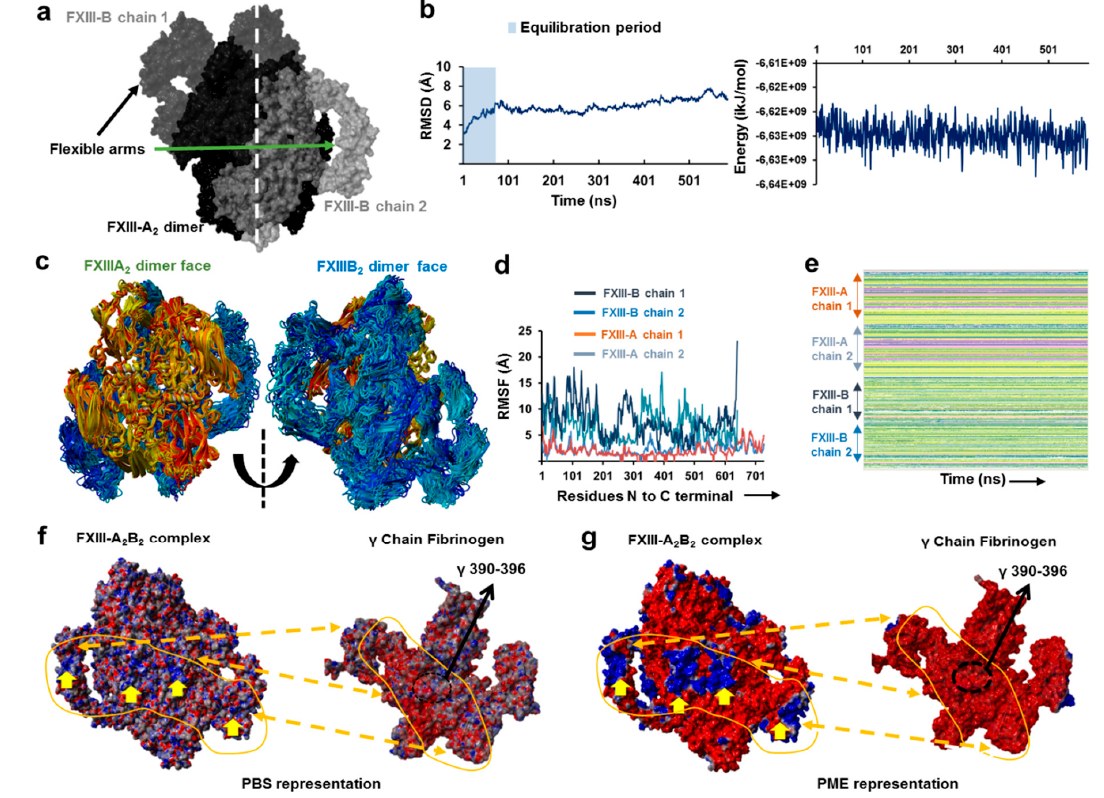
Figure 3. The all-atom structure of the FXIII-A 2 B 2 complex. ( a ) is the symmetrical representation of the best modeled all-atom structure of the FXIII-A 2 B 2 complex. The structure has been depicted by its molecular surface in di ff erent shades of black and gray for the individual chains of FXIII-A and FXIII-B subunits. ( b ) shows the C- α backbone RMSD and the total energy graphs for the MD simulation conducted on the FXIII-A 2 B 2 complex structure model. ( c ) are aligned simulation snapshots from the MD simulation conducted on FXIII-A 2 B 2 complex structure represented with FXIII-A subunit face (left) and the FXIII-B subunit face (right). The snapshots of FXIII-A and FXIII-B subunits are depicted in ribbon format with colors ranging between yellow-red and cyan-blue for either subunit, respectively. ( d ) shows the graph representing RMSF for the FXIII-A 2 B 2 complex structure MD simulation, with individual chains represented by di ff erent color as mentioned in the inset. ( e ) represents the secondary structure profile of individual chains of FXIII-A and FXIII-B subunits for the FXIII-A 2 B 2 complex structure MD simulation. ( f ) is the PBS-based electrostatic surface representation of the FXIII-A 2 B 2 complex structure (left) and γ chain of fibrinogen (right) taken from fibrinogen crystal structure (PDB ID: 3GHG). Red color indicates negative surface electrostatic potential, whereas blue represents positive potential. Indicated positive electrostatic patches on the FXIII-A 2 B 2 complex structure are likely to interact with negatively charge bearing regions in and around the FXIII interaction site of fibrinogen γ chain (the specific residues are numbered and indicated with a black arrow). ( g ) is the same view as ( f ) but electrostatic surface representation has been done with the PME method. The prominent electrostatic patches on the FXIII-B subunit are marked with yellow arrows in ( f , g ). The complementary electrostatic regions between FXIII and fibrinogen γ chain have been marked with dotted arrows and continuous uneven lines covering the shape of the region in ( f , g ).